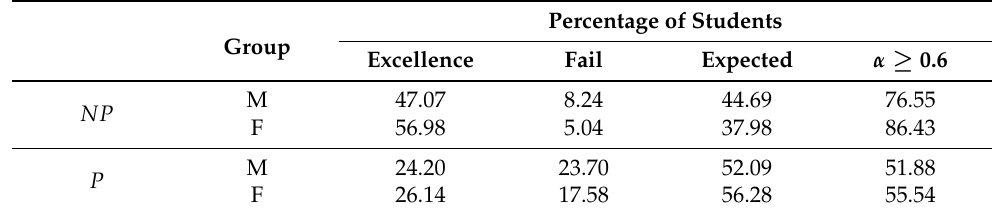
Table 10. Gender of the students that did not participate in the support program ( NP ) and